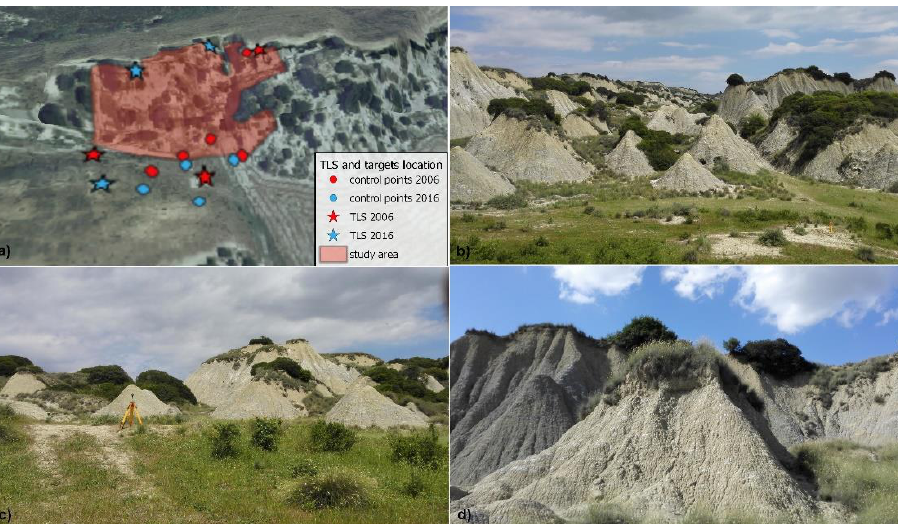
Figure 2. ( a ) 3D view of the study area and location of TLS and control points in both 2006 and 2016 surveys; ( b ) the surveyed biancana landscape characterised by isolated domes at the middle and at the base of the slope; ( c ) dome-shaped features at the base of a slope, showing one of the highest-resolution control points (targets) used to overlap the scans; ( d ) a typical dome-shaped feature with vegetation on its top; rills are visible on the slope.